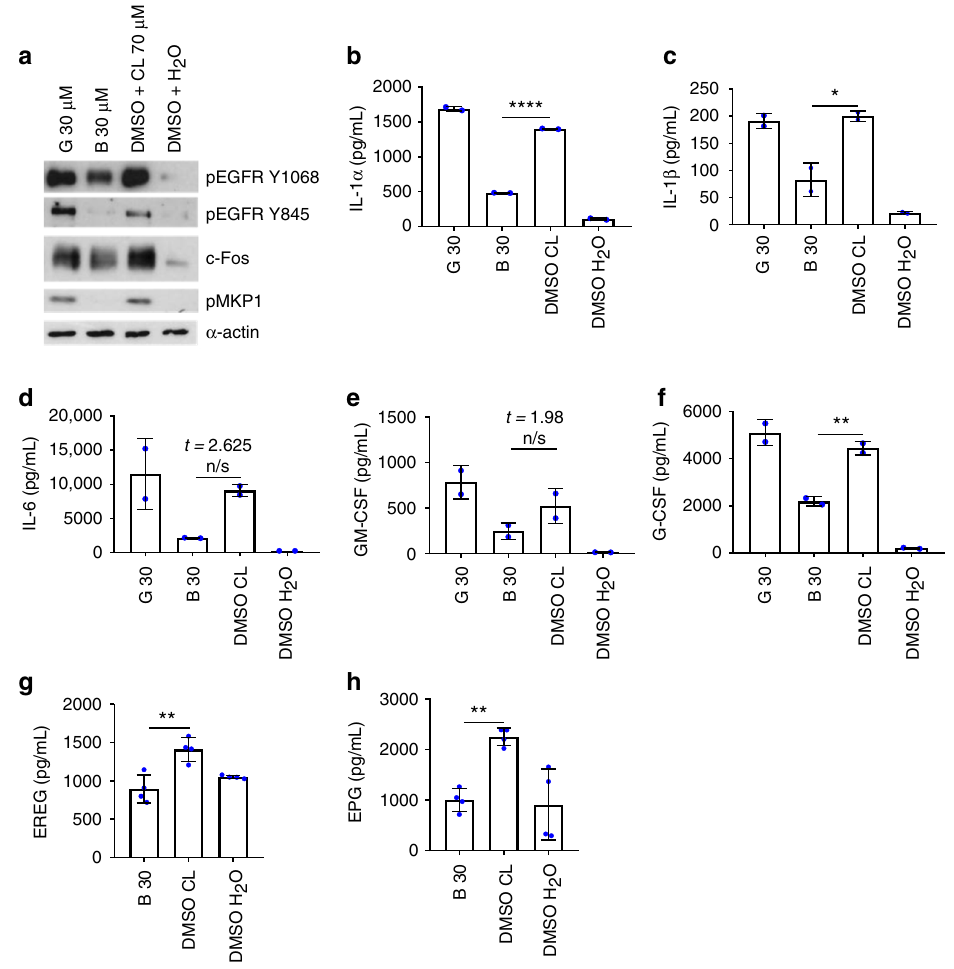
Fig. 6 Calcium is required for candidalysin-triggered immune responses and lies upstream of EGFR. Pre-treatment of TR146 cells with a calcium chelator (Bapta- AM 30 µ M) reduced levels of pEGFR Y1068 and Y845, c-Fos, pMKP1 ( a ), IL-1 α ( b ), IL-1 β ( c ), G-CSF ( f ), EREG ( g ) and EPG ( h ), following candidalysin exposure. This is not observed when using the potassium inhibitor glibenclamide (30 µ M). IL-6 ( d ) and GM-CSF ( e ) are not signi fi cantly suppressed by either inhibitor, though a reduction is observed. Protein lysates were taken at 2h post infection for western blot analysis, cytokines assessed at 24h post infection via luminex. Unmatched, one-way ANOVA with Bonferroni multiple comparison ’ s test was used to assess statistical signi fi cance. Images and graphs are representative of 2 ( a , g , h ) or 3 ( b – f ) independent experiments, respectively. Error bars represent SD. * p <0.05, ** p <0.01, *** p <0.001, n.s. p